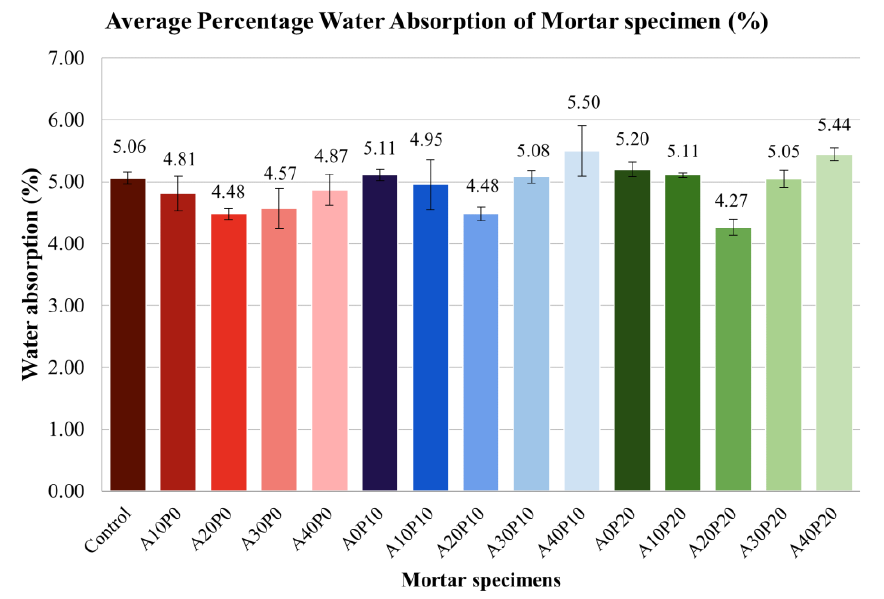
Figure 8. Average water absorption of mortar specimens.